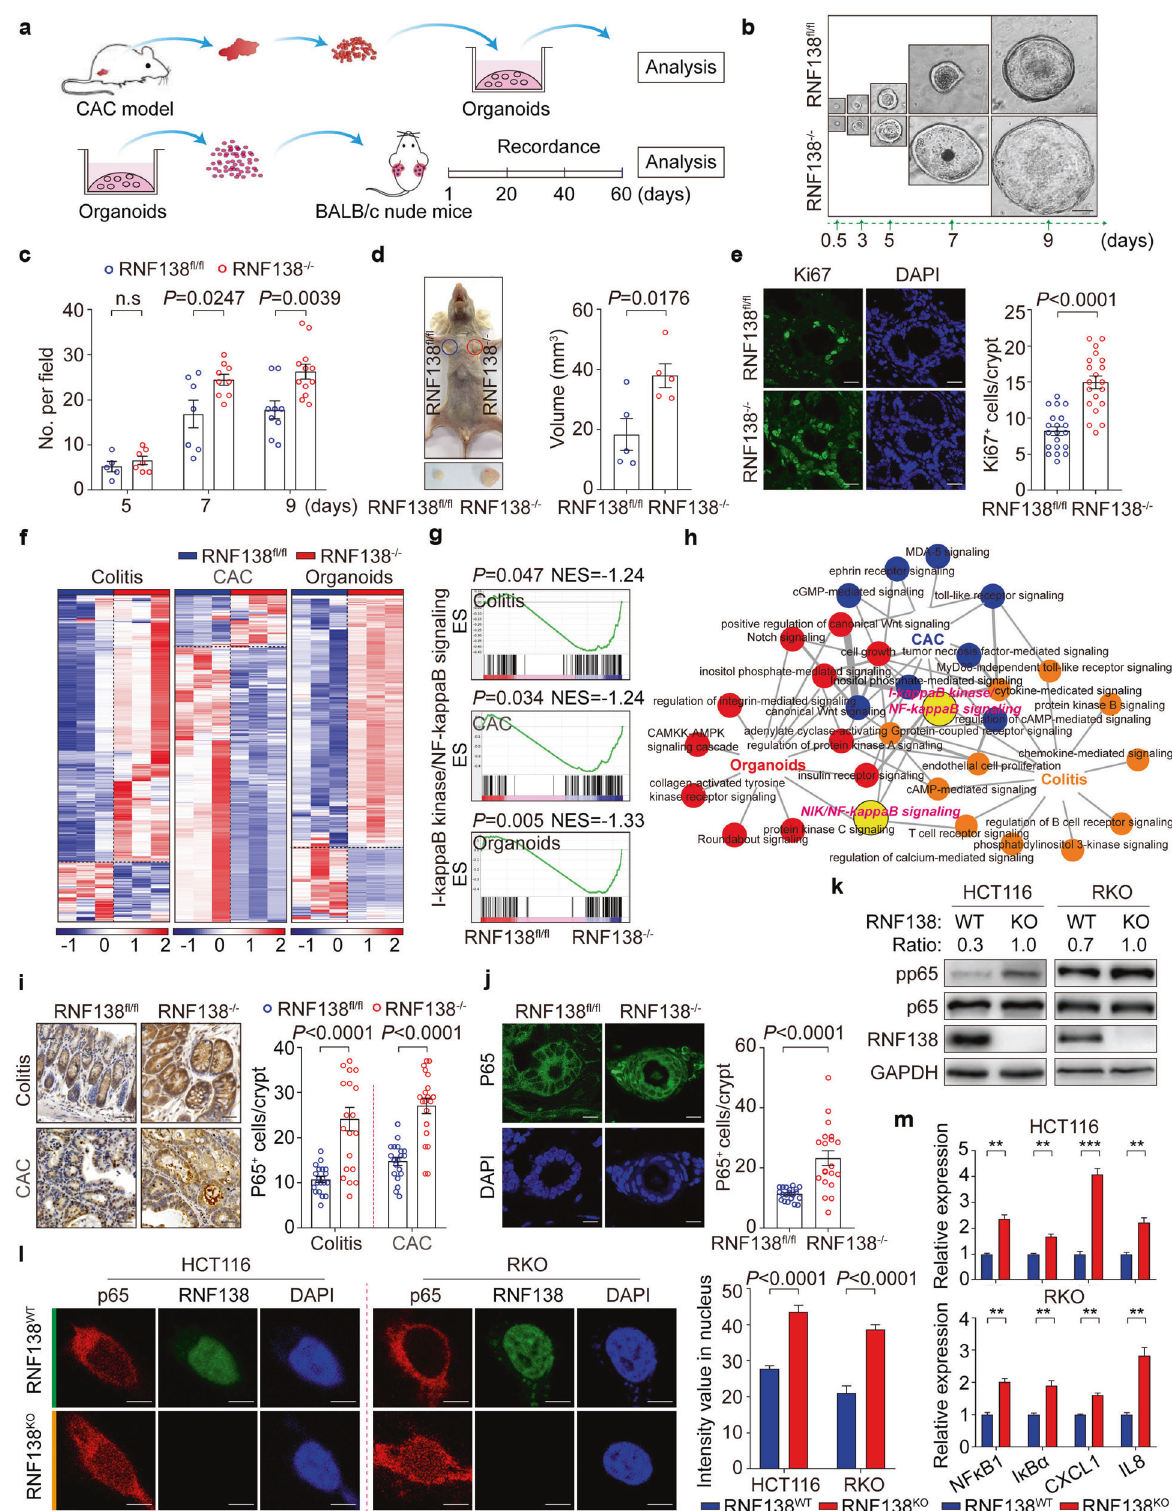
In brief, poor prognosis in CRC patients signi fi cantly correlates with the elevated NF- к B signaling coincided with RNF138 down- regulation in the af fi liated tumors. Therefore, we highlighted the possibility of using RNF138 downregulation as indicator for both prognosis and the therapeutic interventions targeting the NF- κ B